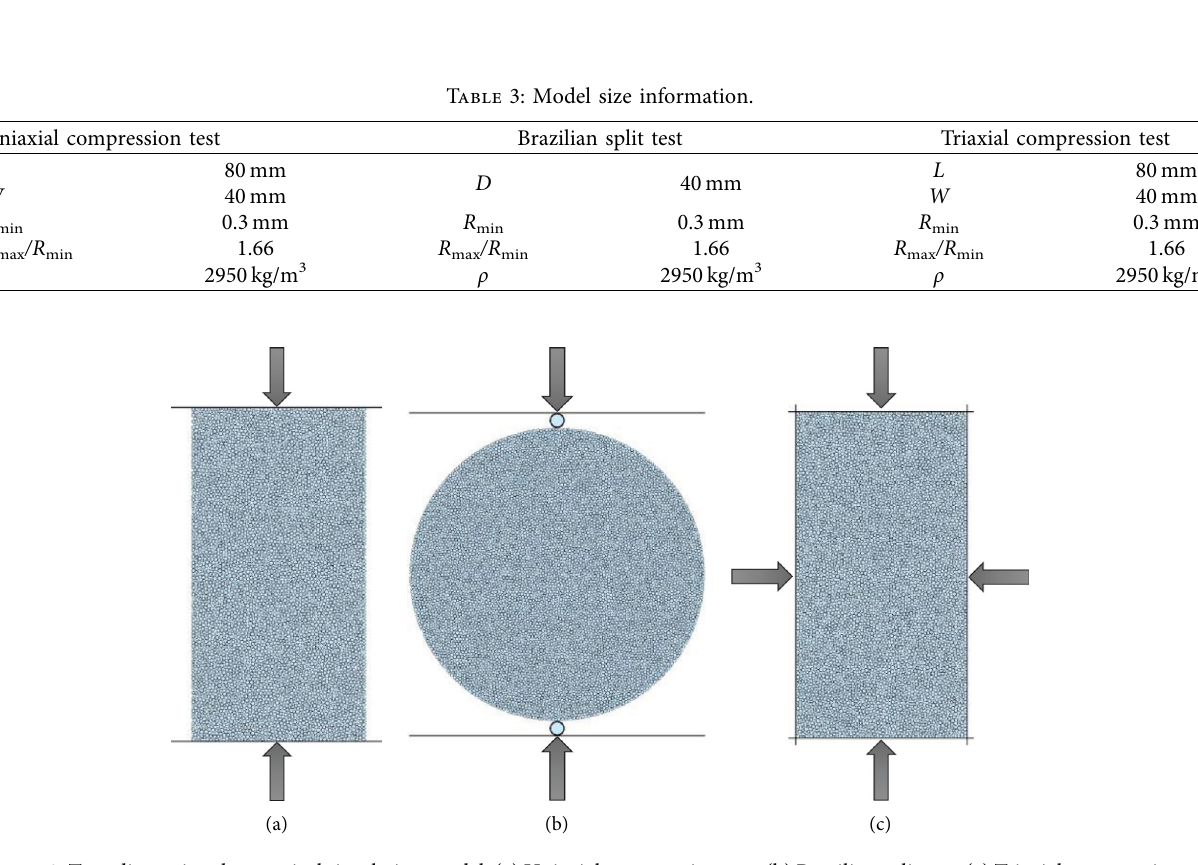
Figure 3: Two-dimensional numerical simulation model. (a) Uniaxial compression test. (b) Brazilian split test. (c) Triaxial compression